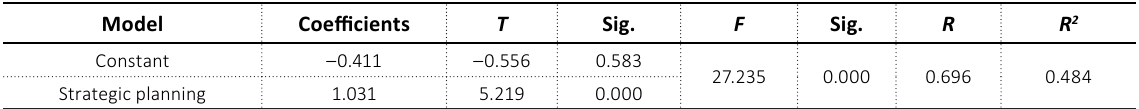
Table 8. The impact of strategic planning on the learning and growth perspective